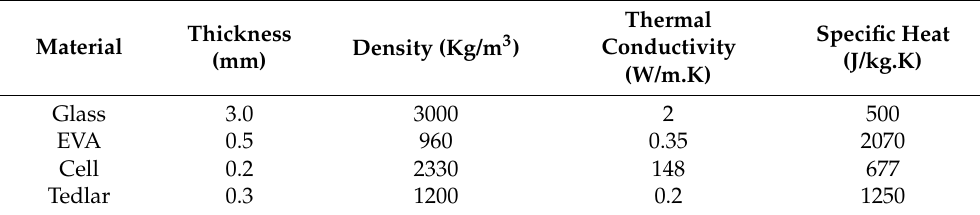
Table 1. Thermophysical characteristics of PV layers [26]. “This article was published in Elsevier, 186, Duan, J, A novel heat sink for cooling concentrator photovoltaic system using PCM-porous system, 116522, Copyright Elsevier (2021)”.